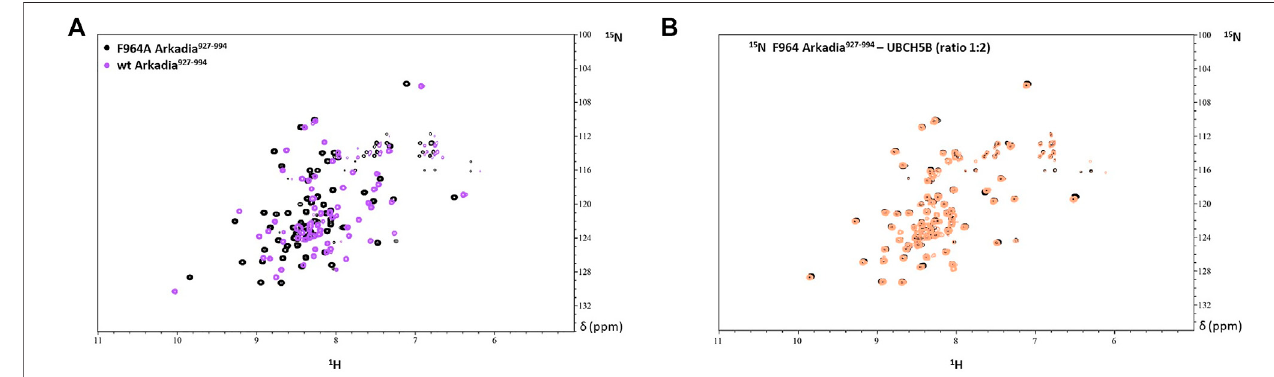
FIGURE 13 | (A) Overlay of the 1 H- 15 N HSQC spectrum of F964A and wt Arkadia RING domain (black and purple, respectively). (B) Overlay of the 1 H- 15 N HSQC spectrum of F964A before (black) and after (orange) the addition of UBCH5B to a 1:2